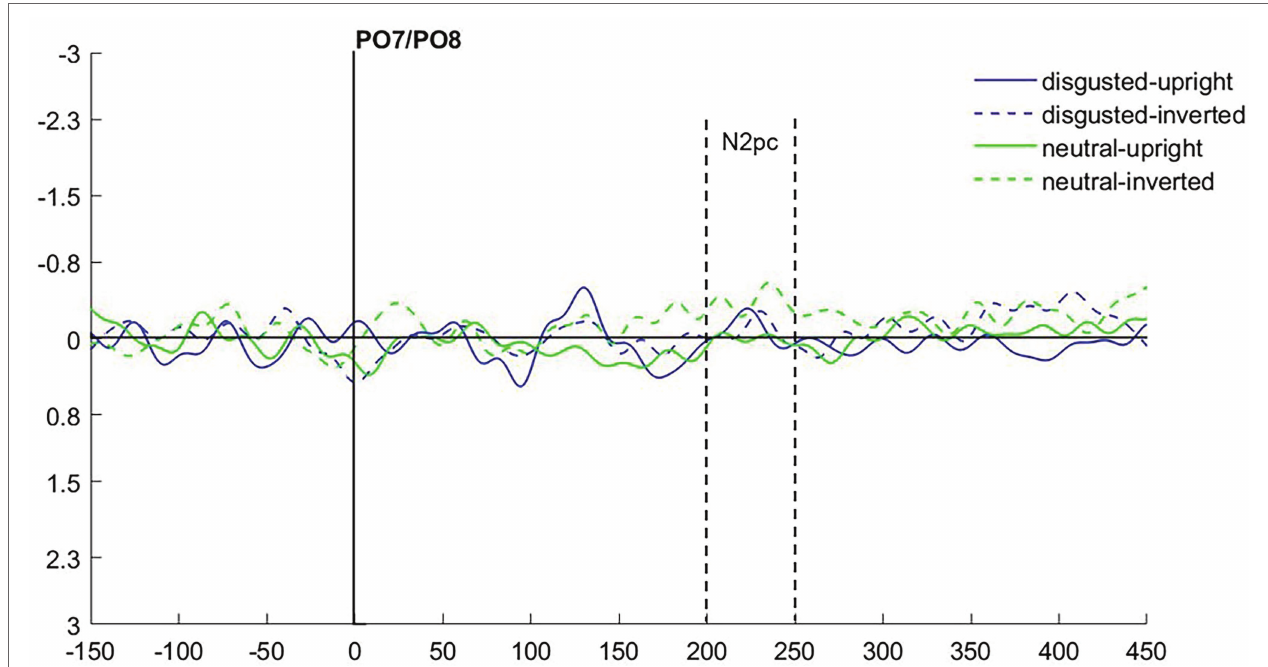
FIGURE 7 | Differences in contra- minus ipsilateral event-related potentials (ERPs) in Experiment 2 after cue onset depending on cueing displays’ Distractor Emotion and Cue Orientation.